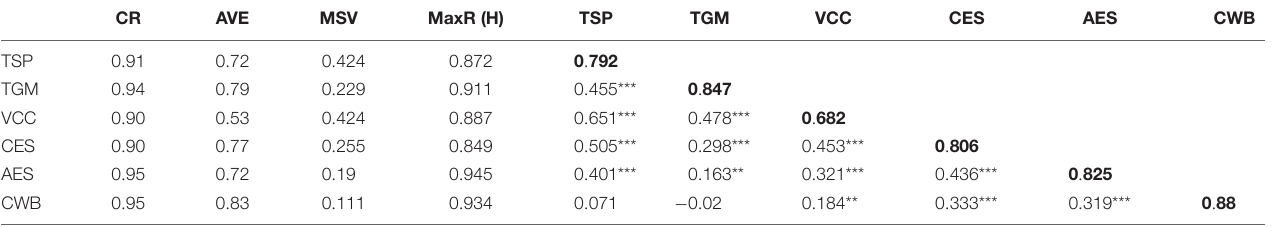
TABLE 3 | Discriminant validity.